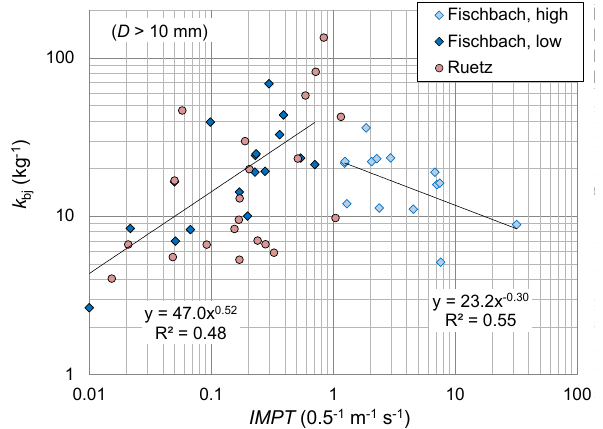
Figure 9. Linear calibration coefficient k bj (for D > 10mm) vs. im- pulse rate IMPT. Fischbach: data points marked “high” and “low” refer to impulse rates higher and lower than 1 (0.5 − 1 m − 1 s − 1 ), respectively. The regression lines are based on the Fischbach data only.